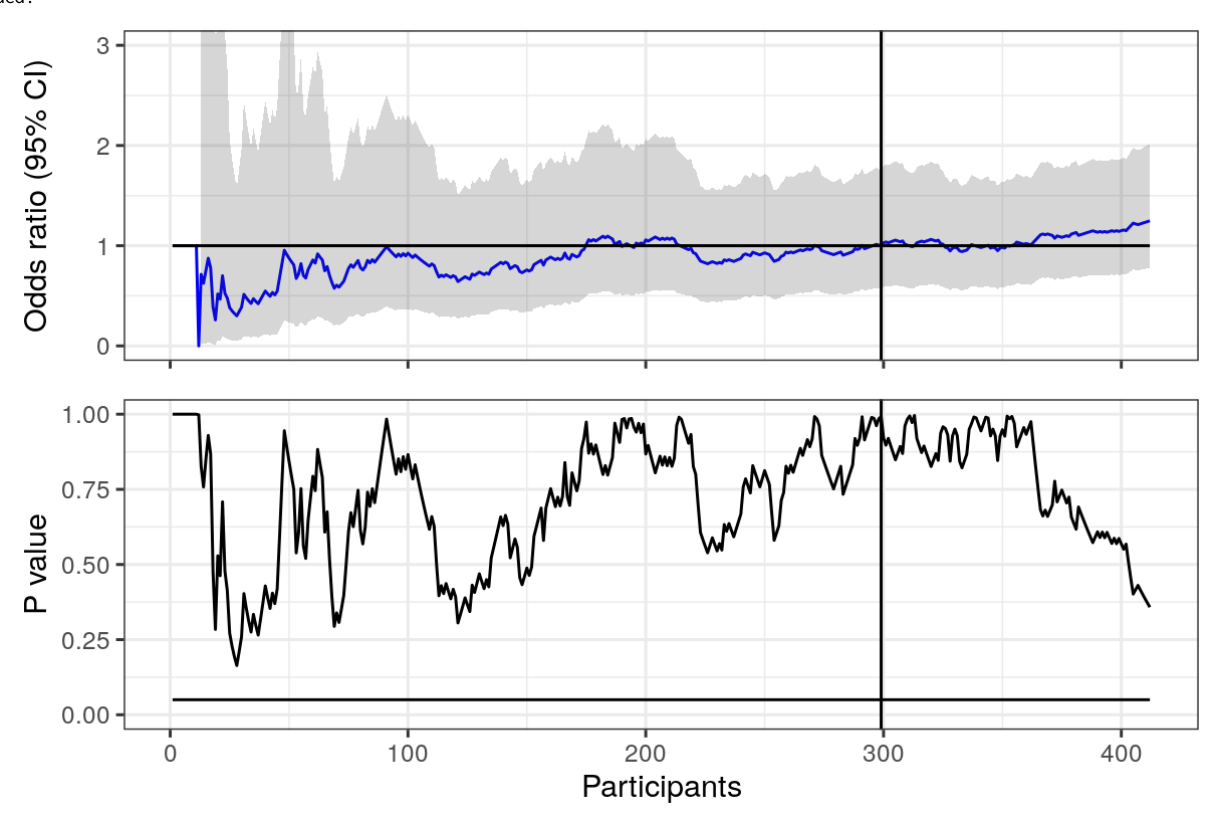
Figure 1. Prolonged abstinence: odds ratios and P values calculated using actual data from trial, plotted over time (number of responders in the study). Horizontal lines represent null value (OR 1) and the .05 statistical significance line. Vertical line represents where the first 6 months of recruitment